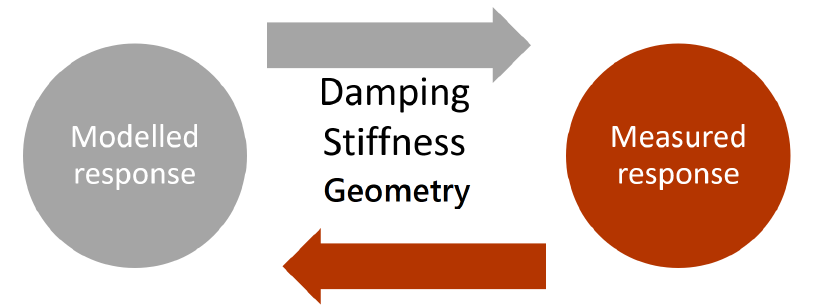
Figure 15. The model–measurement loop formed to iteratively improve both model fidelity and machine design by comparing first principle models and experimental observations.